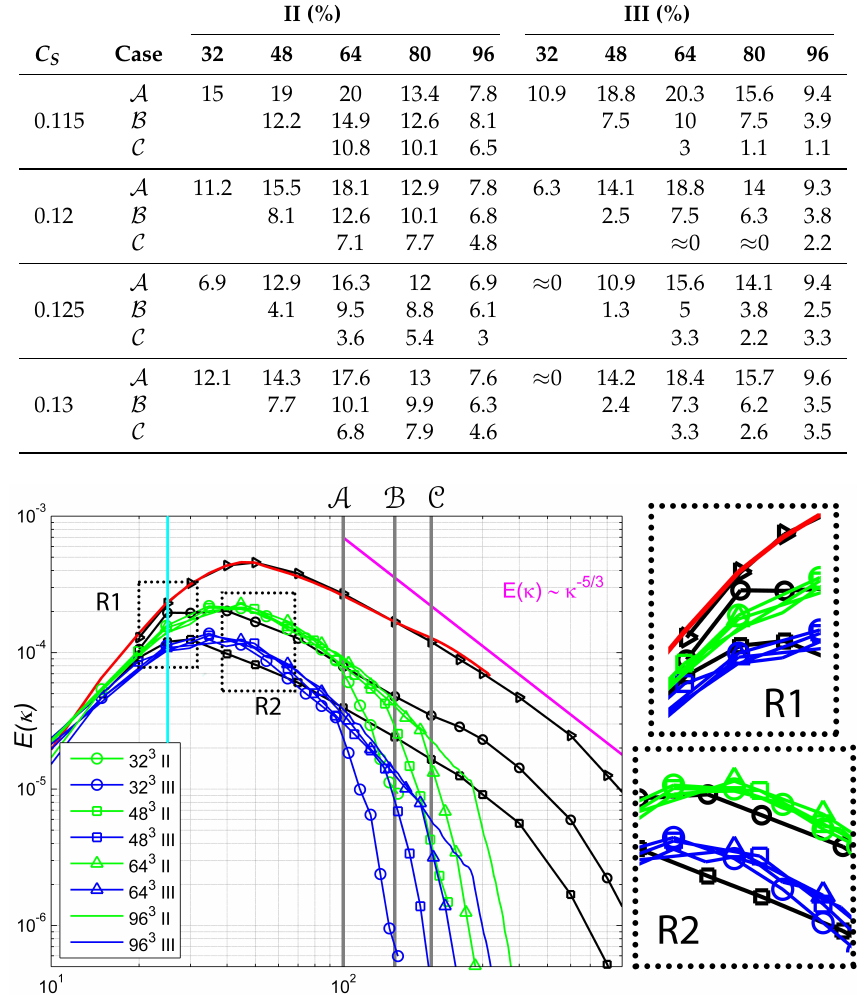
Table 3. A summary of errors (reported in percentage) using the energy spectra obtained by CBC [25].